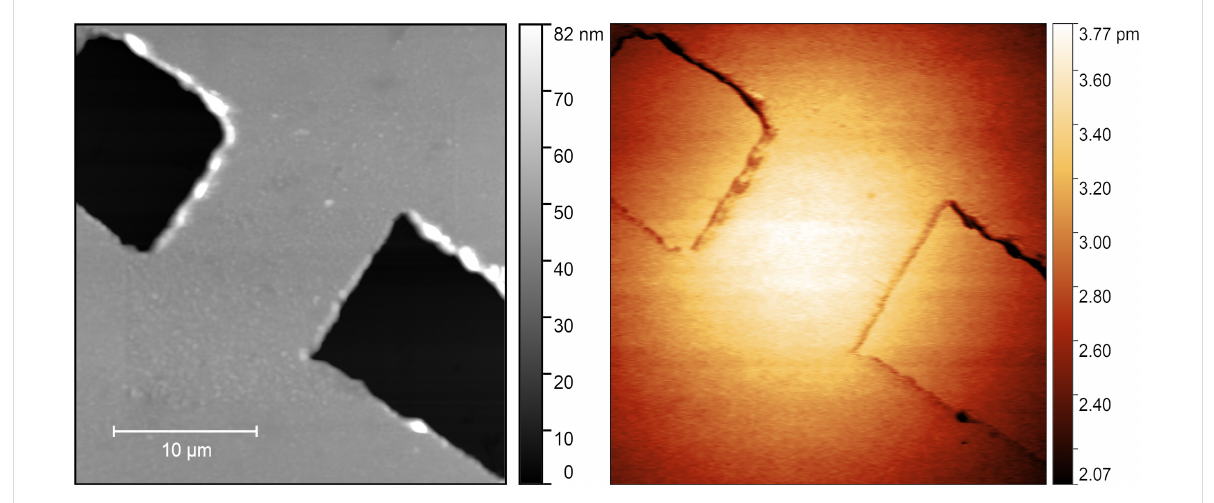
Figure 9: Left: Topography of the active element. AFM scan of 30 × 30 μ m 2 area of a 10 μ m wide constriction in a 48 nm thin silver film. Right: Expan- sion of active element due to applied voltage V( t ), as defined above, for a current density of 44 mA/ μ m 2 . Both scans are 512 × 512 pixels yielding a spatial step size of 58.7 nm.